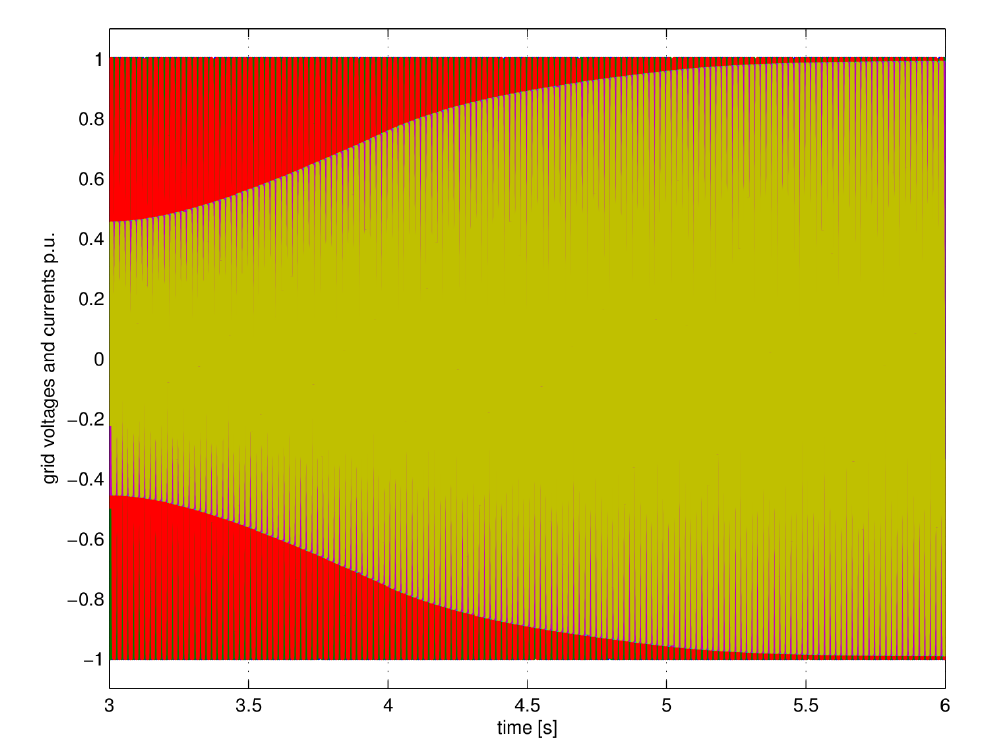
Figure 10. Grid Voltages (red) and Currents (yellow) variation in p.u. due to a slow change of reference of the power peak